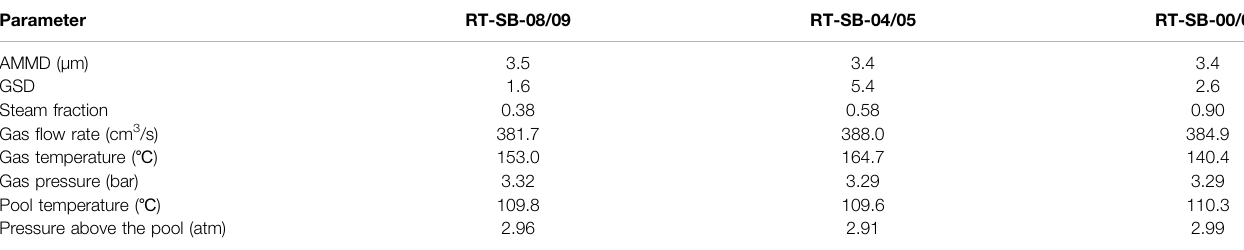
TABLE 4 | Main parameters about conditions of LACE-Espana